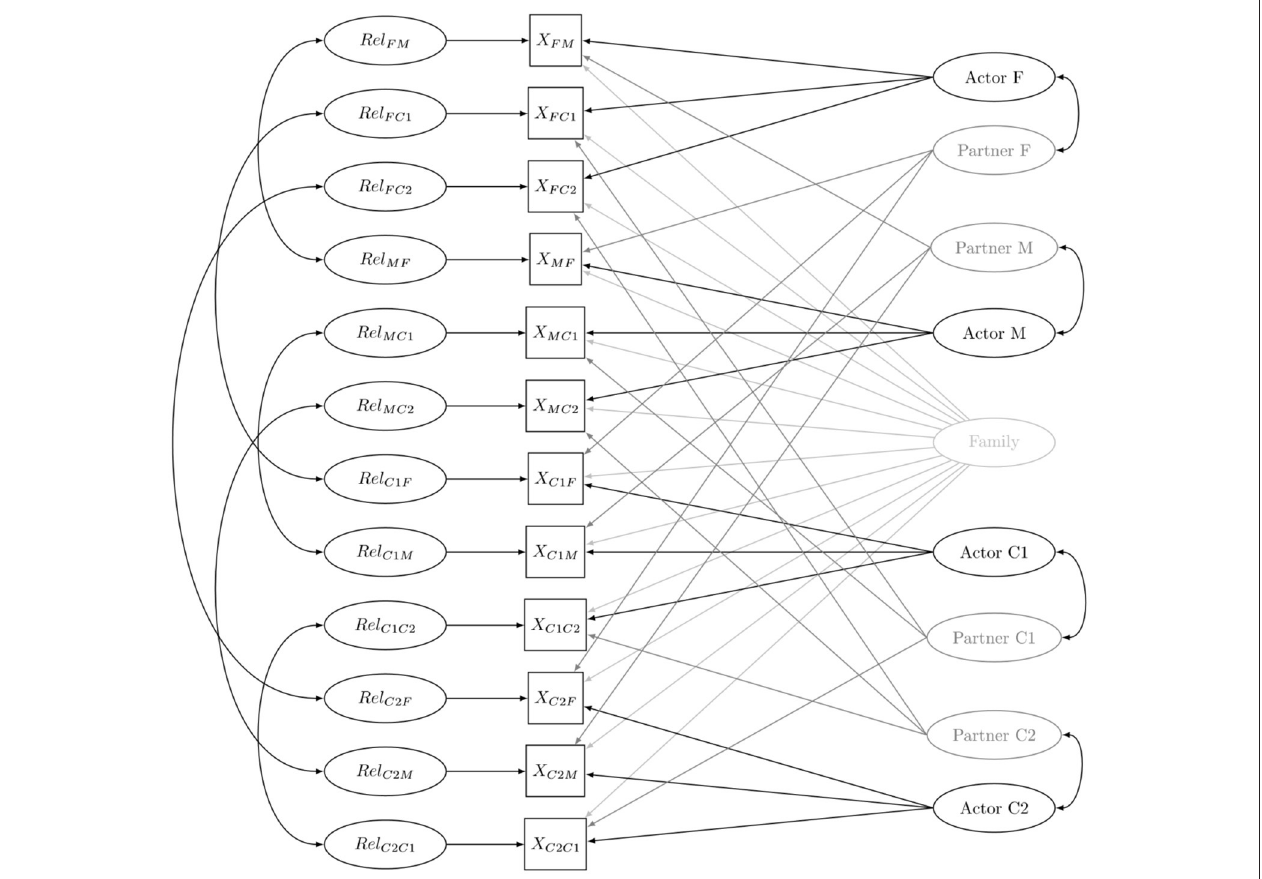
FIGURE 1 | The family social relations model (M, mother; F, father; C1, oldest child; C2, youngest